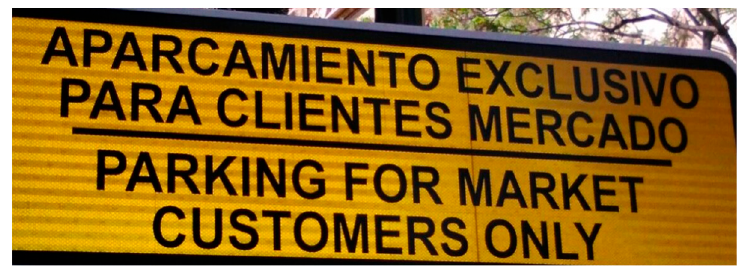
Figure 20. Valencia: Spanish-English sign on a car park.